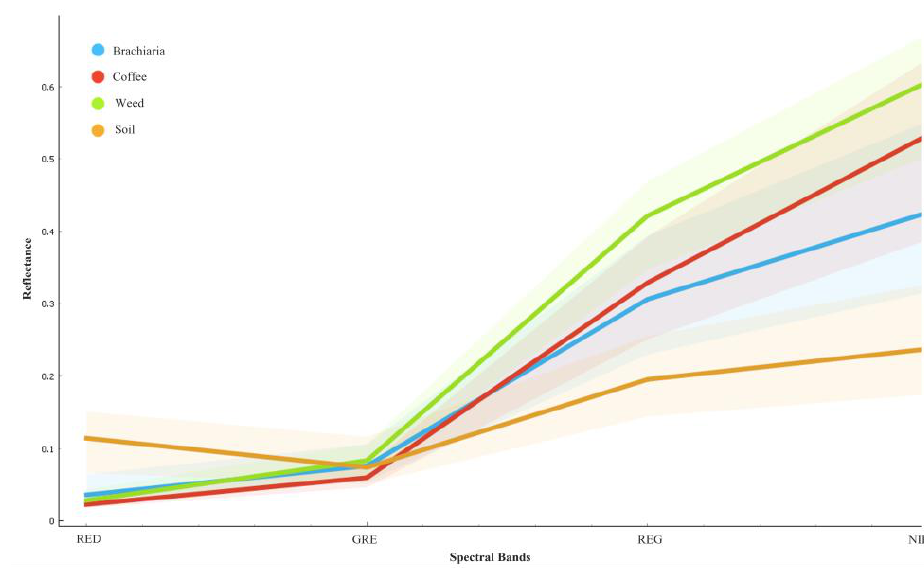
Figure 7. Spectral signature of each study class.